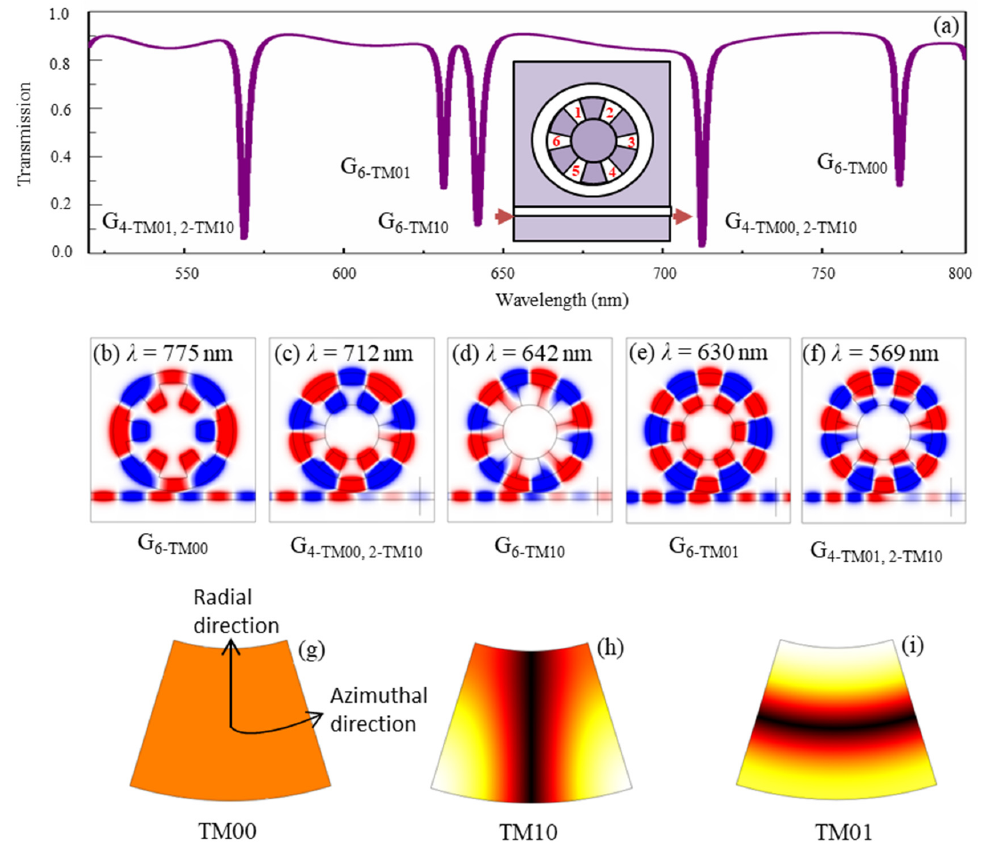
Figure 5. ( a ) The transmission spectrum of the periodic metal-air grooves surrounded by a ring waveguide and coupled with a straight waveguide, the H z -field distributions at the transmission dips of ( b ) G 6-TM00 with λ = 775 nm, ( c ) G 4-TM00,2-TM10 with λ = 712 nm, ( d ) G 6-TM10 with λ = 642 nm, ( e ) G 6-TM01 with λ = 630 nm, and ( f ) G 4-TM01,2-TM10 with λ = 569 nm, and the three fundamental eigenmodes existed in the single air groove in metal for ( g ) TM 00 mode, ( h ) TM 10 mode, and ( i ) TM 01 mode.